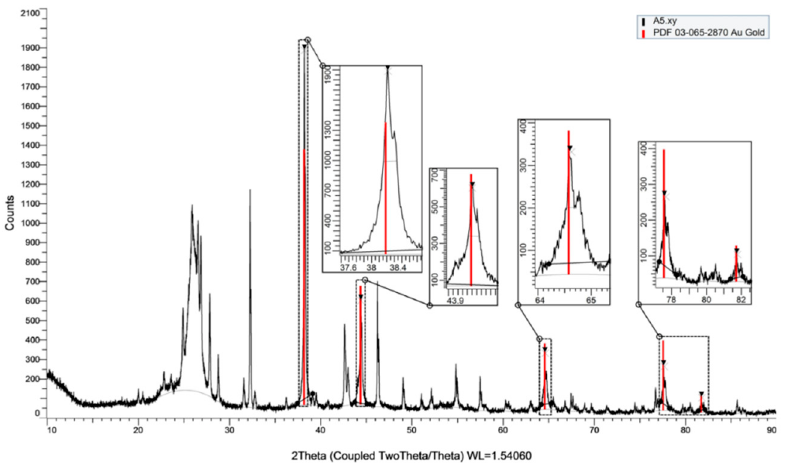
Figure 7. SPCE/AuNS working electrode surface prepared with optimal configuration (applied potential of (cid:3398) 0.2 V vs. Ag/AgCl for 1200 s using a precursor of 10 mM) characterized with XRD.